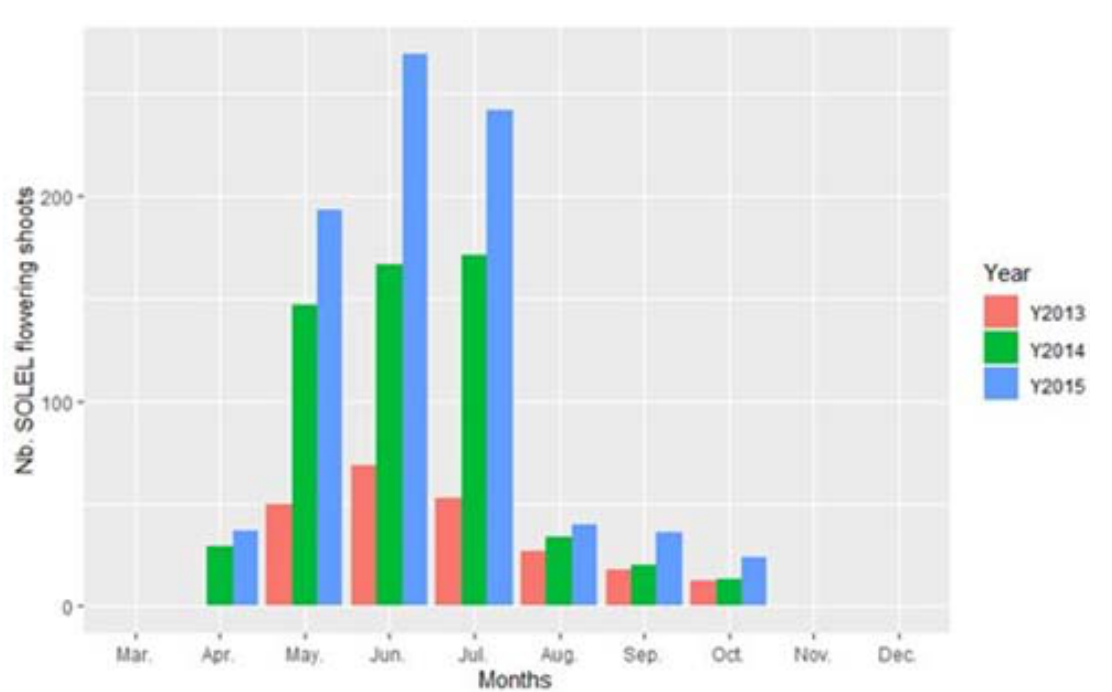
Figure 5. Solanum elaeagnifolium flowering potential, calculated as the total number of flowering shoots per month, during three growing cycles (2013, 2014, and 2015) at Chott Mariem, Tunisia.